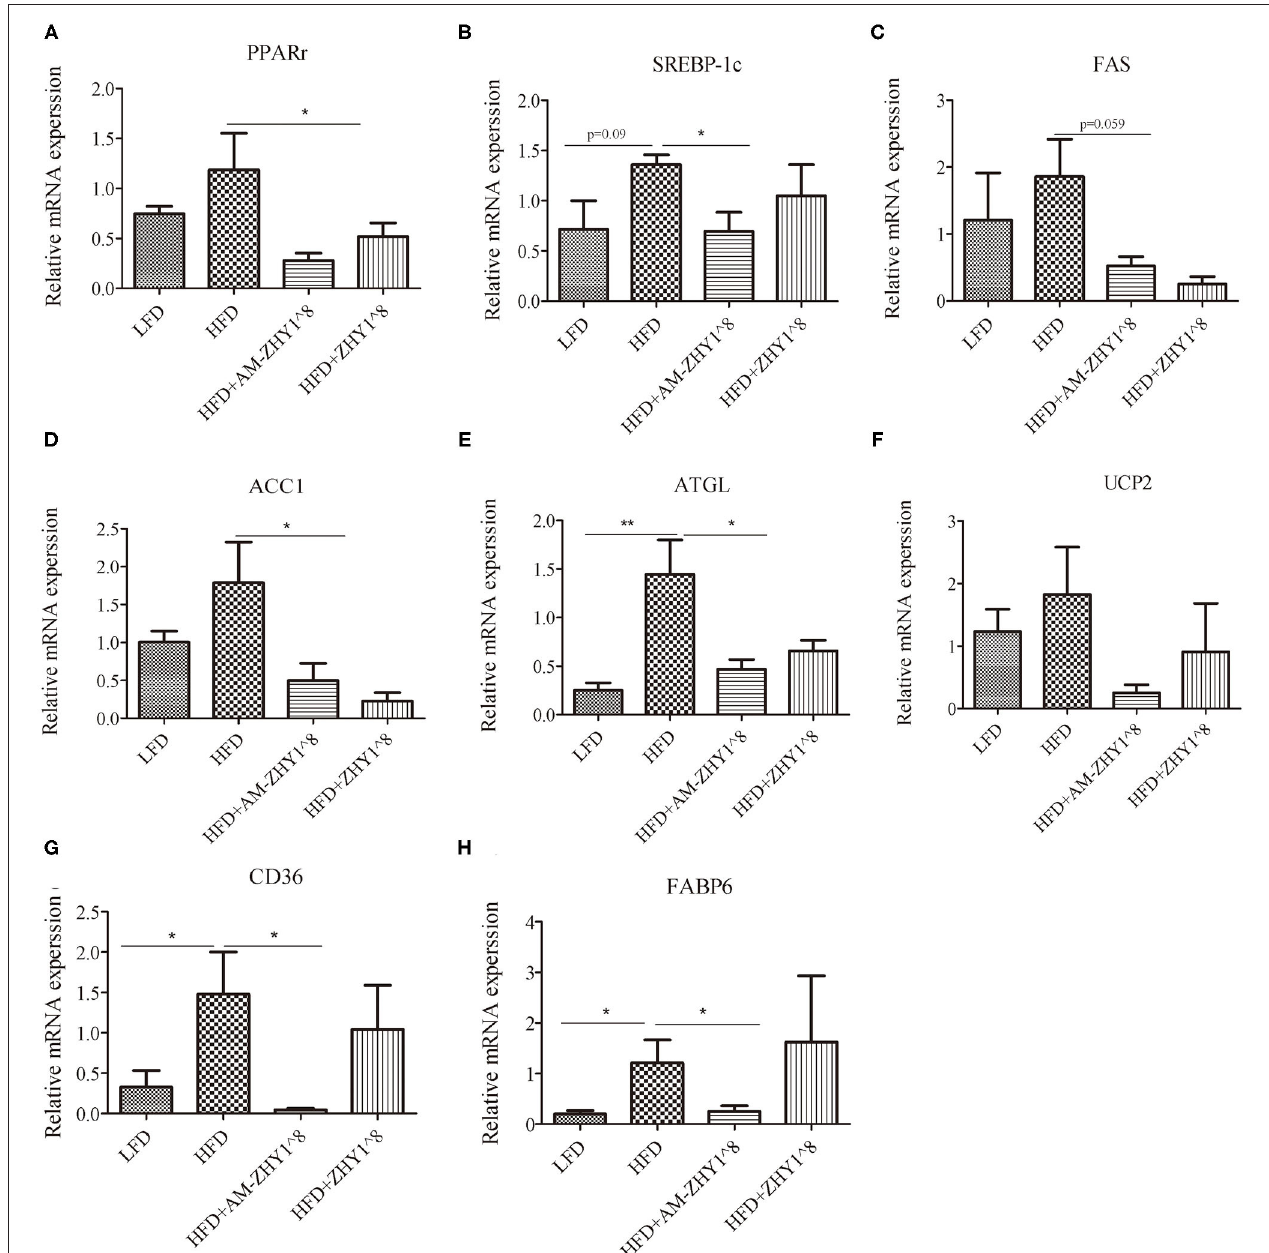
FIGURE 5 | Relative mRNA expression of lipid metabolic-related genes PPAR γ (A) , SREBP-1c (B) , FAS (C) , ACC1 (D) , ATGL (E) , UCP2 (F) , CD36 (G) , FABP6 (H) of the livers of zebrafish in different groups. Data are presented as mean ± SEM ( n = 6). The asterisks on the horizontal line represent significant differences between the two groups. * p < 0.05, ** p <